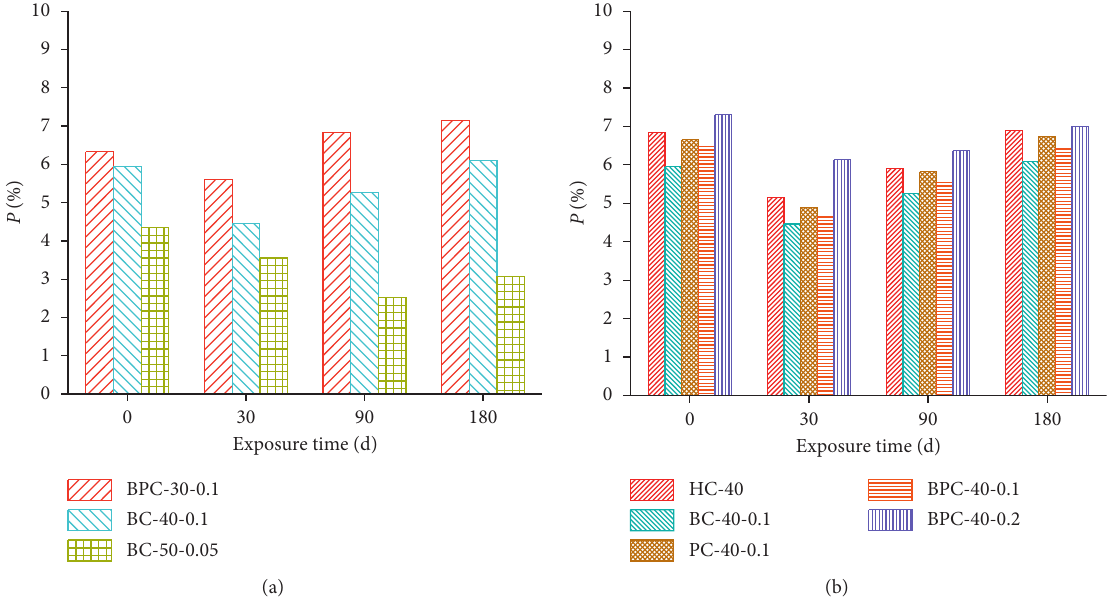
Figure 13: Theoretical pore volume of BPFRC. (a) Different strength grades. (b) Different fiber types and